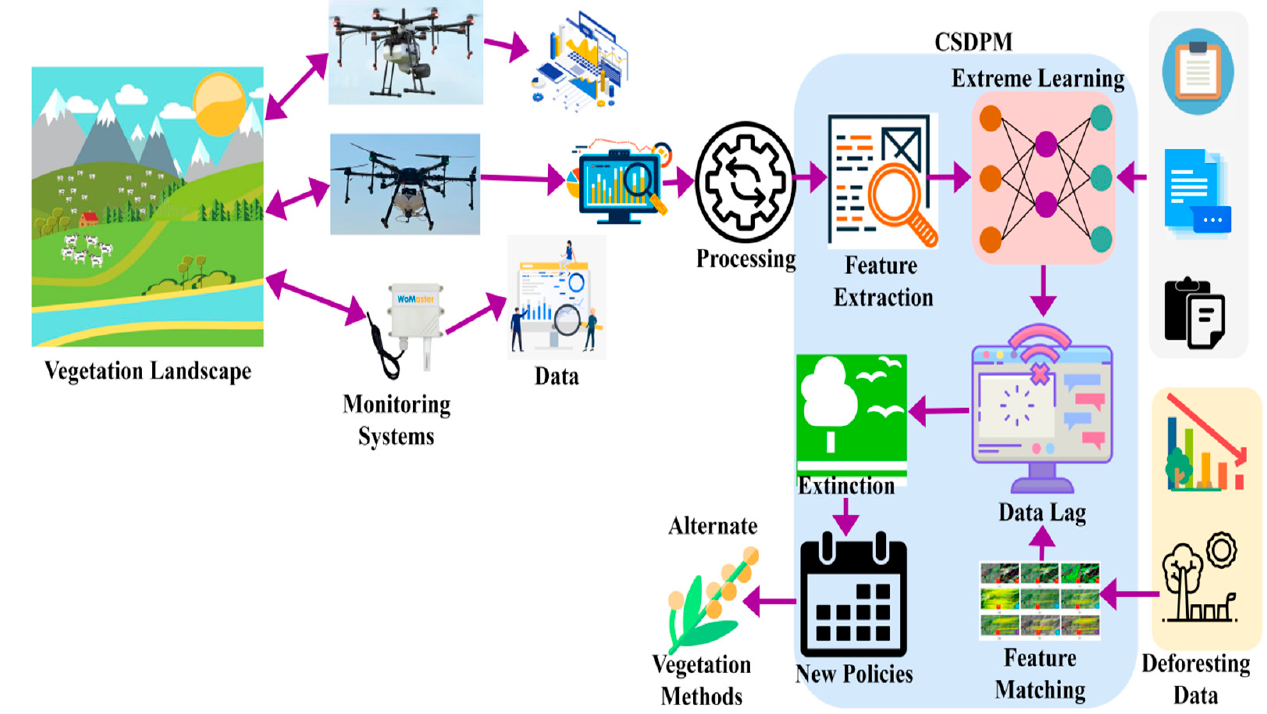
Figure 1. Proposed method representation.